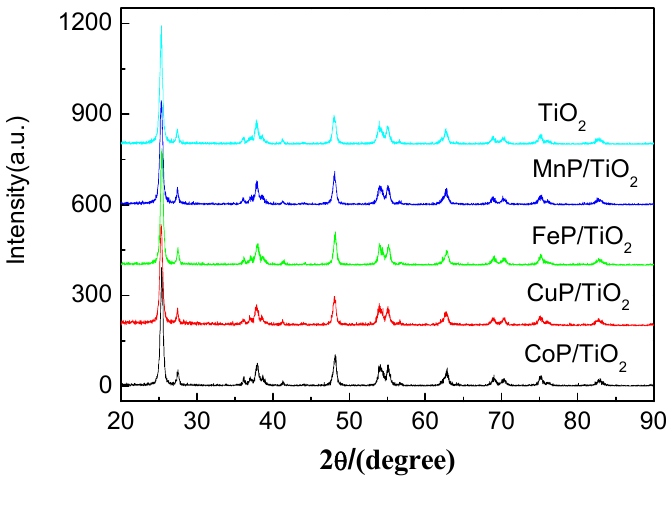
(P25) and metalloporphyrins-TiO 2